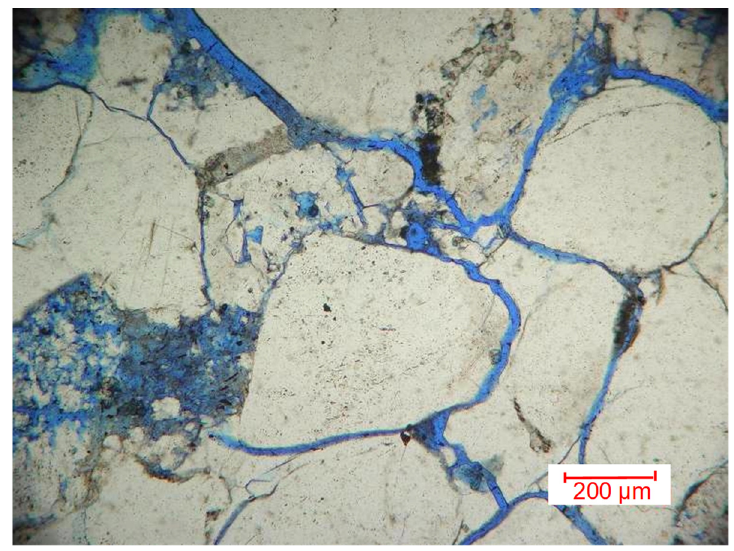
Figure 1. Thin section of a tight sandstone showing microcracks and a complex pore structure.